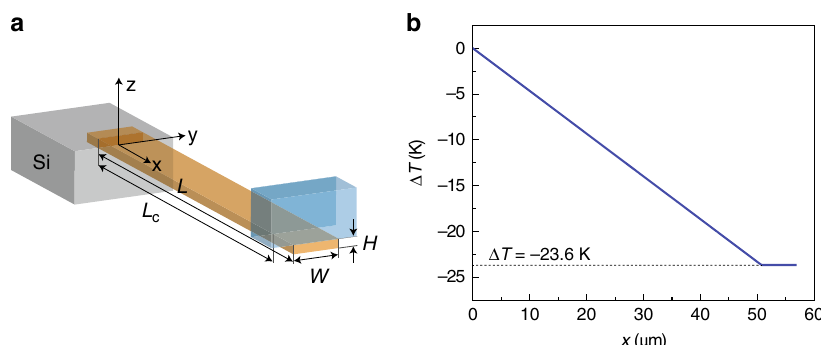
Fig. 3 Heat-transfer analysis. a The geometry of FCNR system used for analytical and fi nite element heat-transfer modeling. b The steady-state temperature along the length of the CdSNR calculated using analytical one-dimensional solution obtained assuming all of the cooling power produced by the YLF crystal fl ows through the CdSNR cross-section at L